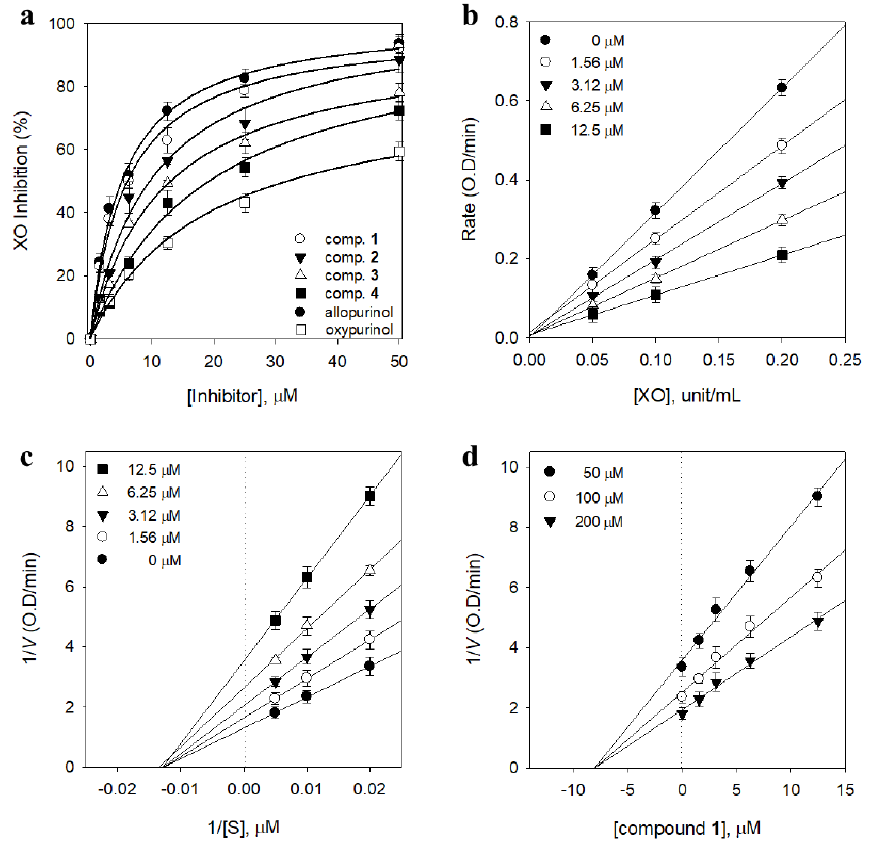
Figure 2. ( a ) Inhibitory effects of compounds 1 − 4 on the activity of xanthine oxidase (XO) based on the oxidation of xanthine to uric acid. ( b ) Catalytic activity of XO as a function of enzyme concentration at different concentrations of compound 1 . ( c ) Lineweaver–Burk plots were constructed for the inhibition of XO by compound 1 . The plot is expressed as 1/velocity versus 1/xanthine (S) with or without an inhibitor in the reaction solutions. ( d ) Dixon plots of XO inhibition by compound 1 . The graphical symbols are substrate concentrations (50 µM, ● ; 100 µM, ○ ; 200 µM, ▼ ).